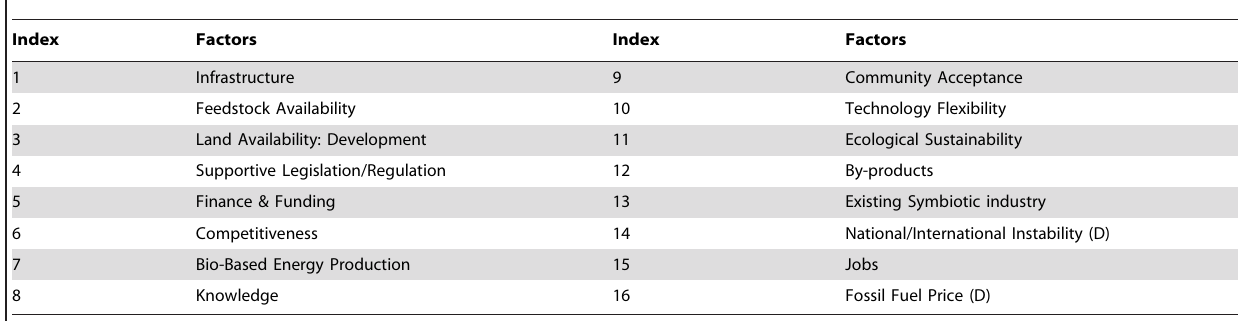
Table 1. Key factors generated by participants.